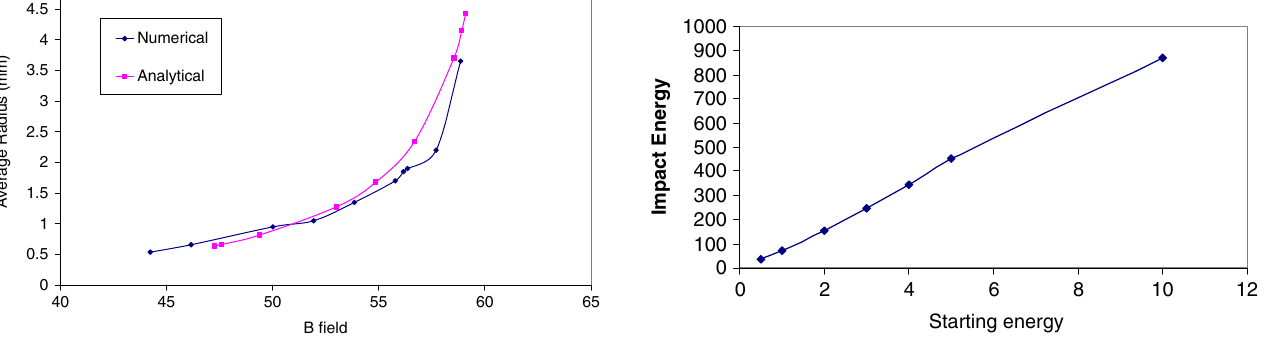
FIG. 11. Impact energy as a function of electron starting energy.